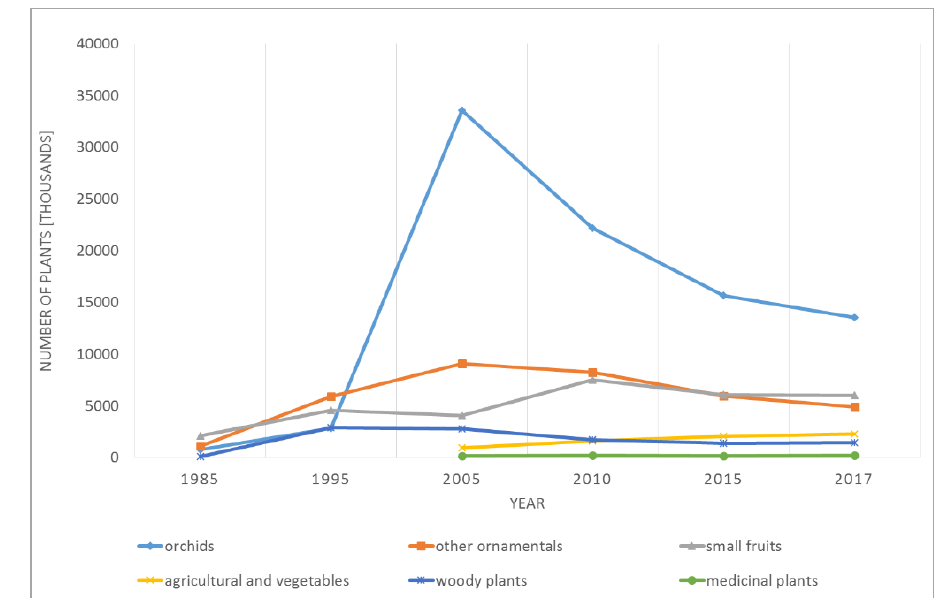
Fig. 2: Plant production numbers of different categories of plants from 1985 to 2017 (stated by ADIVK members, voluntary basis).